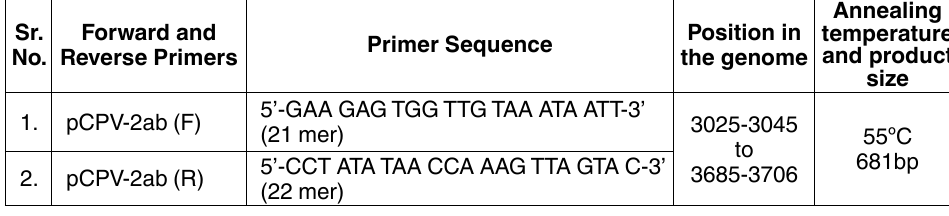
table 2 . Treatment regimens